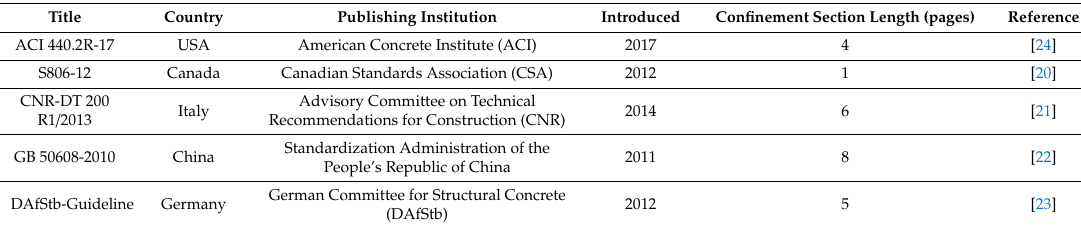
Table 1. Overview of reviewed standards, codes and guidelines.